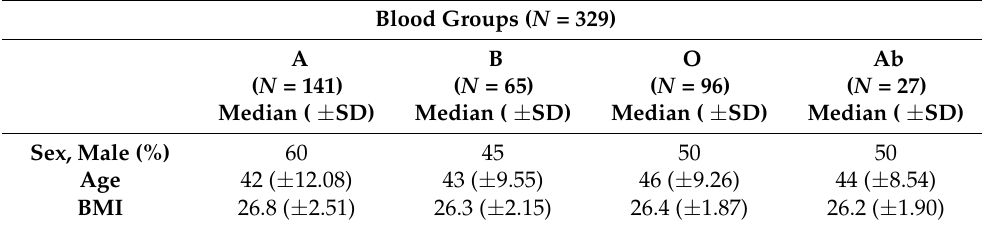
Table 1. Characteristics of all study